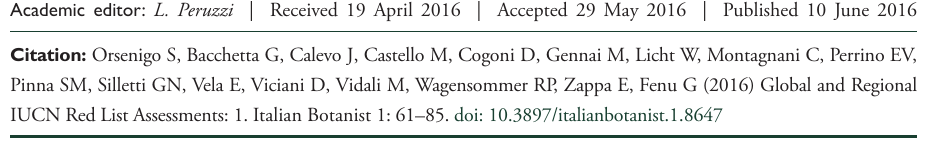
Conservation, extinction risk, IUCN protocol,